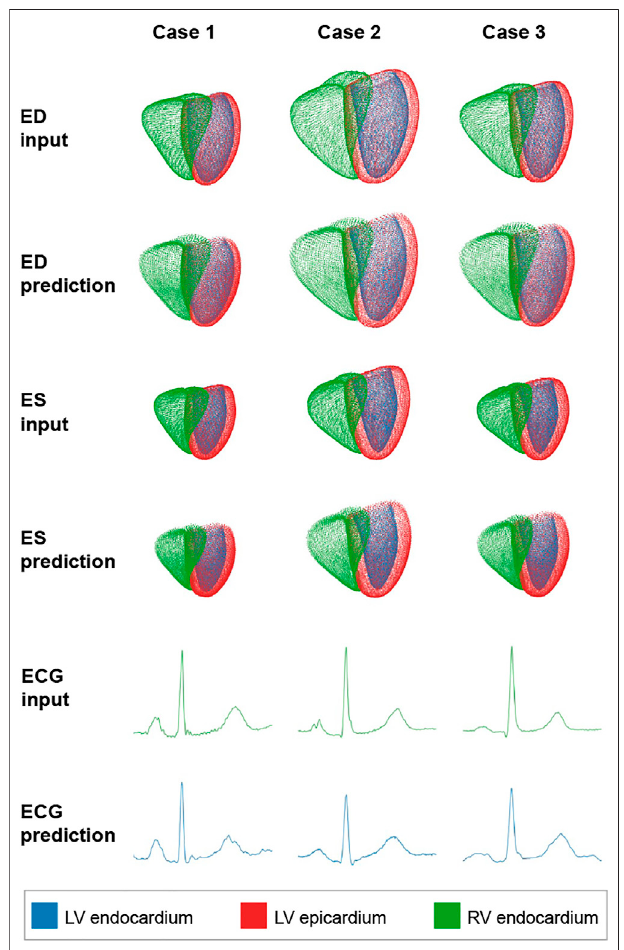
FIGURE 3 | Qualitative reconstruction results of the proposed method for three sample